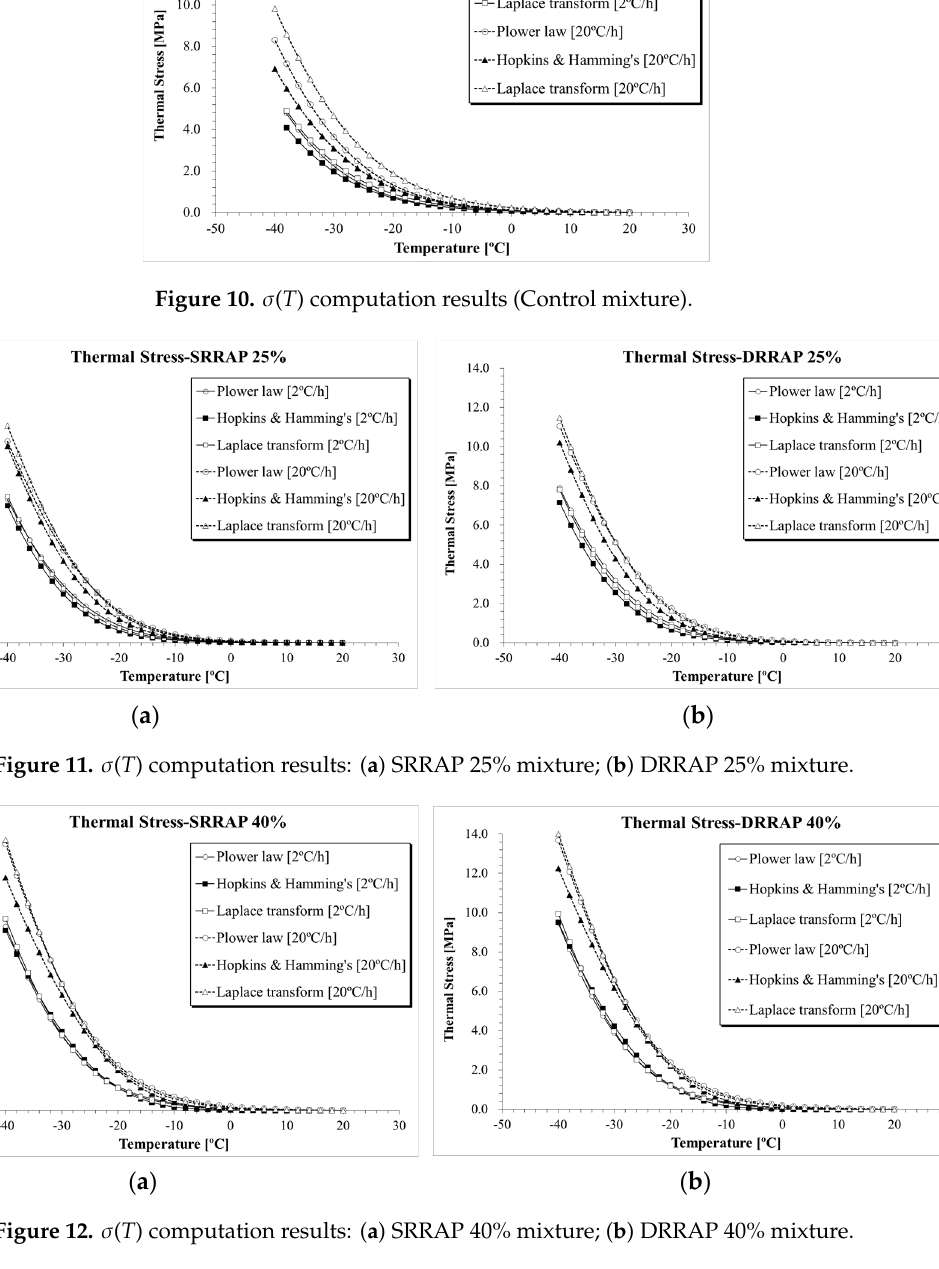
Figure 12. σ ( T ) computation results: ( a ) SRRAP 40% mixture; ( b ) DRRAP 40% mixture.